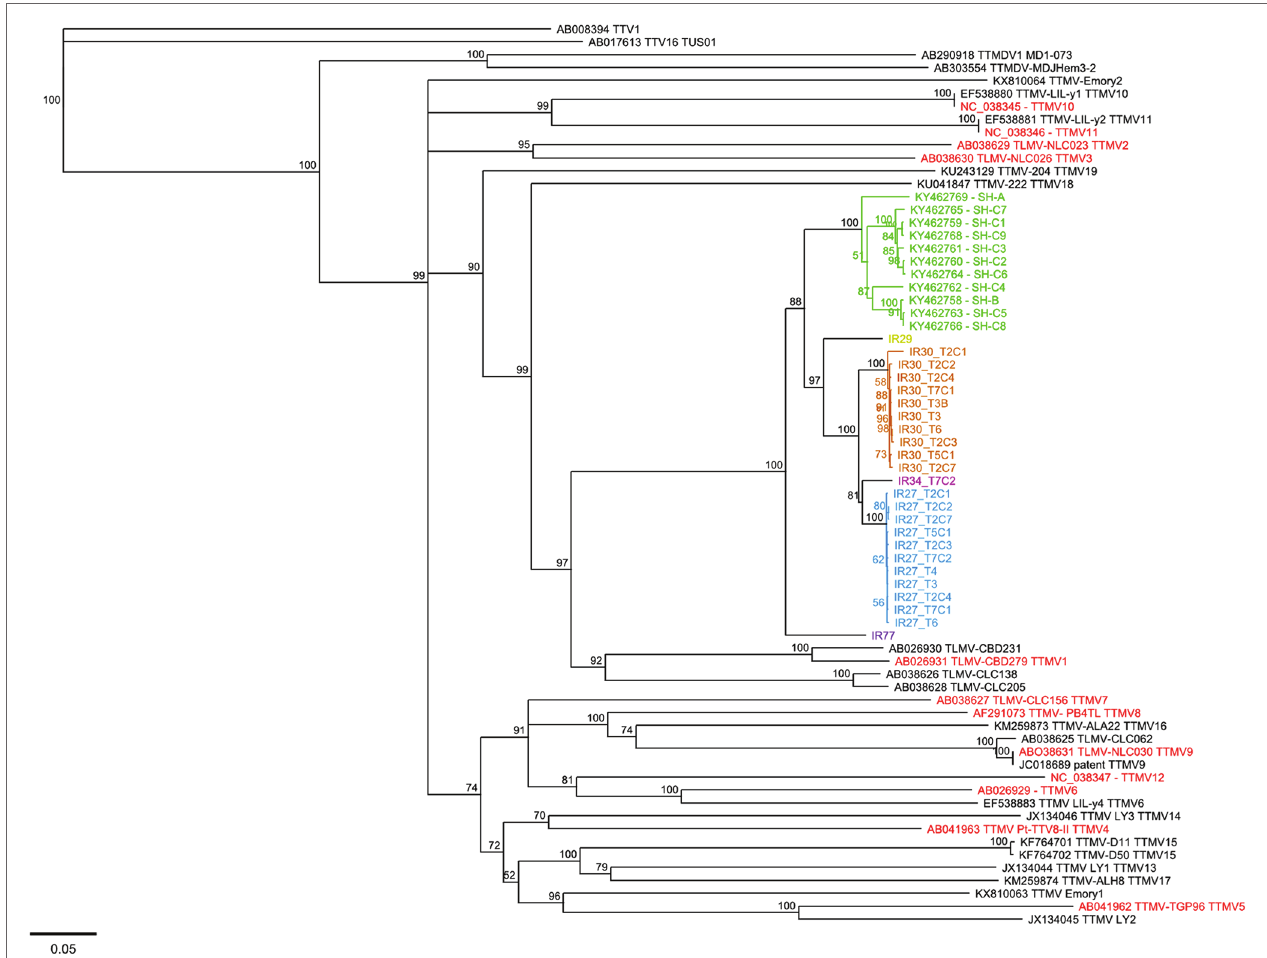
FIGURE 1 | Phylogenetic analysis of TTMV strains based on the nucleotide sequence ORF1. TTMV sequences deposited in GenBank were downloaded. Four reference sequences of TTV and TTMDV strains were also used. Genetic distances were calculated with the Jukes-Cantor model of evolution. The tree was constructed by the neighbor-joining method using Geneious 10.0.7 software (Biomatters Ltd., Auckland, New Zealand) and validated using 1,000 bootstrap pseudo-replicates. Bootstrap values are indicated at each branching point. Scale bars indicate number of nucleotide substitutions per site. The green sequences indicate the 11 TTMV strains reported by Pan et al. (2018). The red sequences indicate the 12 TTMV species defined by ICTV. TTMV-SH-related sequences identified in the present study ( n = 24) were represented by a different color for each patient ( n =